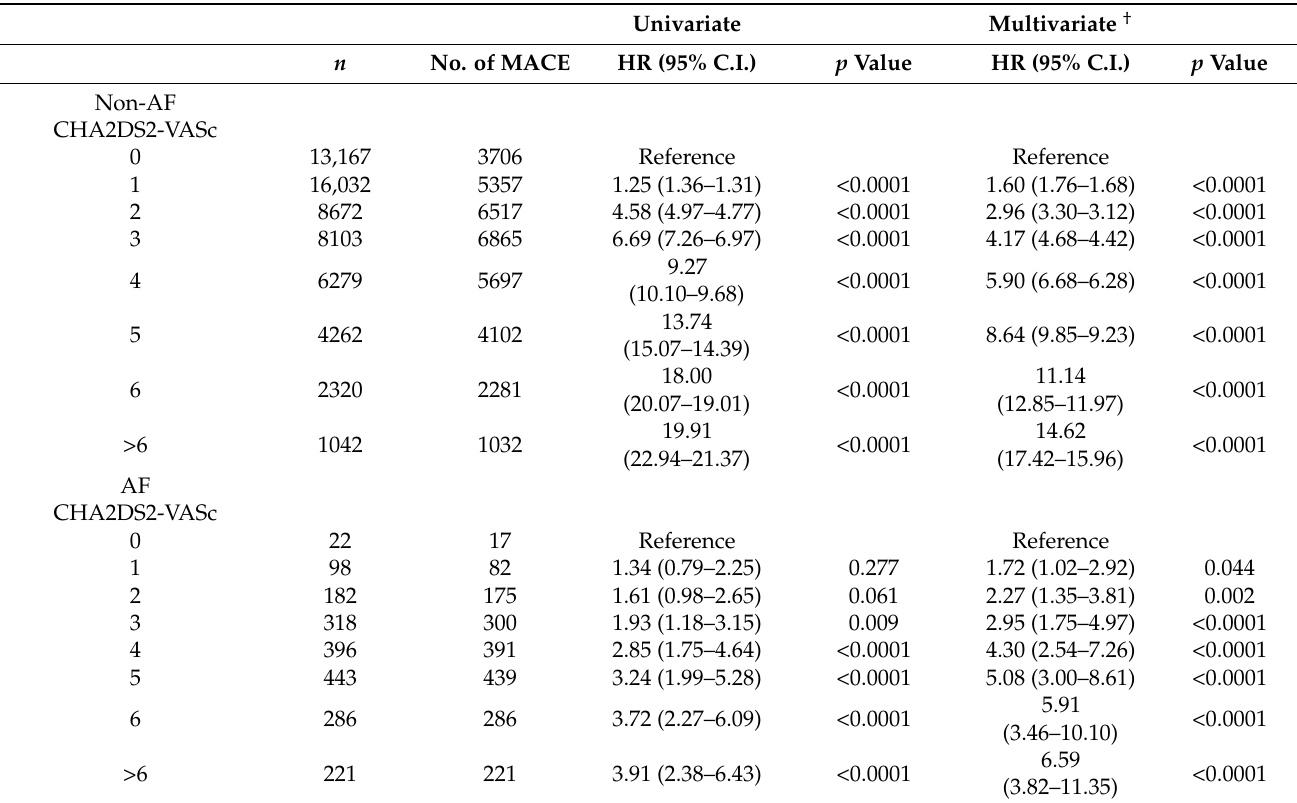
Table 2. Cox proportional hazard model analysis for risk of MACE.